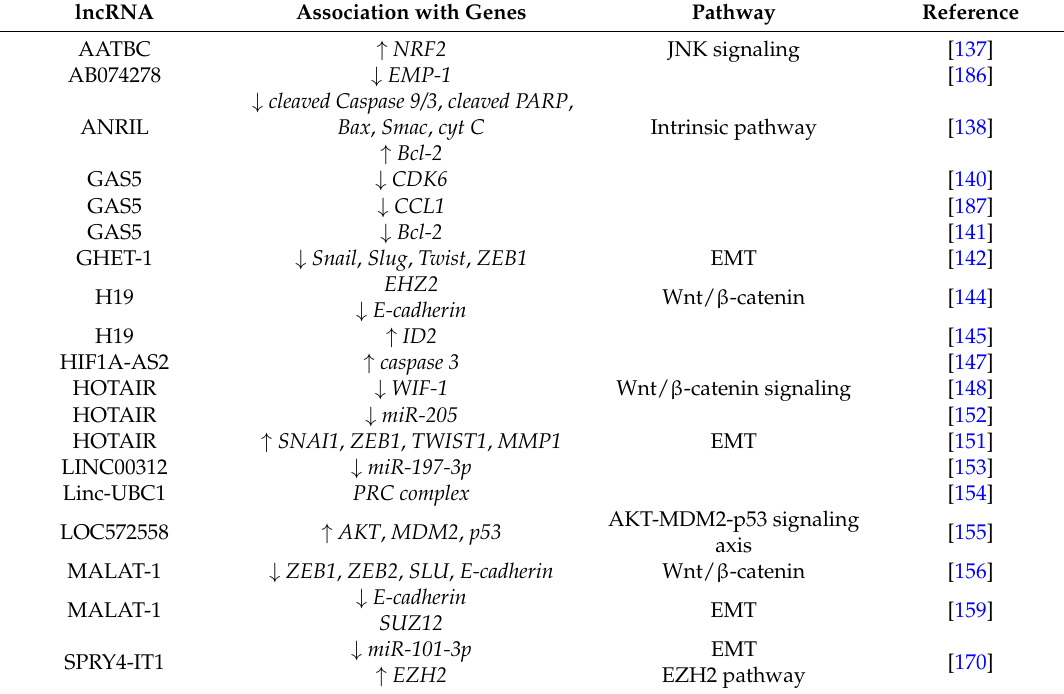
Figure 2. The involvement of lncRNAs in different processes associated with the hallmarks of cancer in bladder malignancies. LncRNAs support the survival and growth of cancer cells ( A ) through interaction with specific target genes and modulation of cell metabolism ( B ). Once the tumor is formed, malignant cells are influenced by non-coding sequences in order to switch towards migratory mesenchymal cells ( C ) within EMT. Apoptosis is also influenced by lncRNAs that are able to target specific genes involved in programmed cell death ( D ) and support the progression of carcinogenesis. Table 3. List of studies evaluating the expression of different lncRNAs and their putative target genes in bladder cancer.